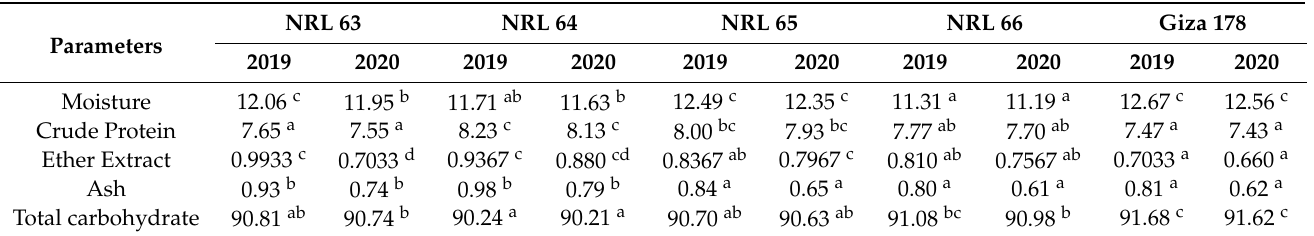
Table 3. Mean performances for chemical composition (%) of milled rice grains of the studied genotypes during the 2019 and 2020 growing